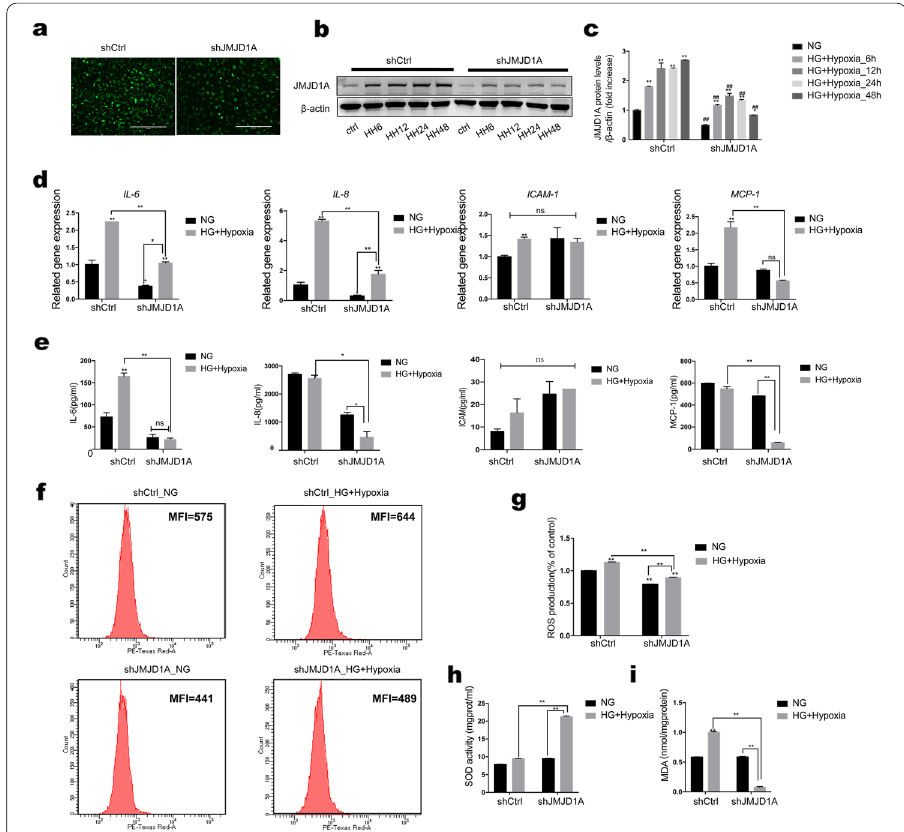
Fig. 8 Knockdown of JMJD1A in HUVECsdecreases inflammation and oxidative stress injury induced by high glucose andhypoxia. a Knockdown of JMJD1A under high-glucose and hypoxic conditions inHUVECs. Western blotting analysis of JMJD1A levels ( b , c ) in HUVECs stablytransduced with shJMJD1A and control scrambled shRNA (shCtrl), and cultured innormal or high-glucose and hypoxic conditions for 6, 12, 24, and 48 h. Cellswere transfected with control shRNA or shJMJD1A for 48 h following combinedstimulation, and qPCR ( d ) and ELISA for IL-6, IL-8, ICAM-1, and MCP-1 ( e ) wereperformed. Downregulation of JMJD1A decreased the secretion of IL-6, IL-8, andMCP-1, but did not affect ICAM-1 secretion. Assays for ROS ( f and g ), MDA ( h ),and SOD activity ( i ) are shown compared with controls. JMJD1A shRNA decreasedthe expression of ROS and MDA level, and increased SOD activity markedlycompared with control shRNA-transfected cells. n 3; * p <0.05 and = ** p <0.01vs. control shRNA-transfected cells. HG, high glucose; HG Hypoxia, combinedstimulus with high + glucose and hypoxia; NG, control; shCtrl, control